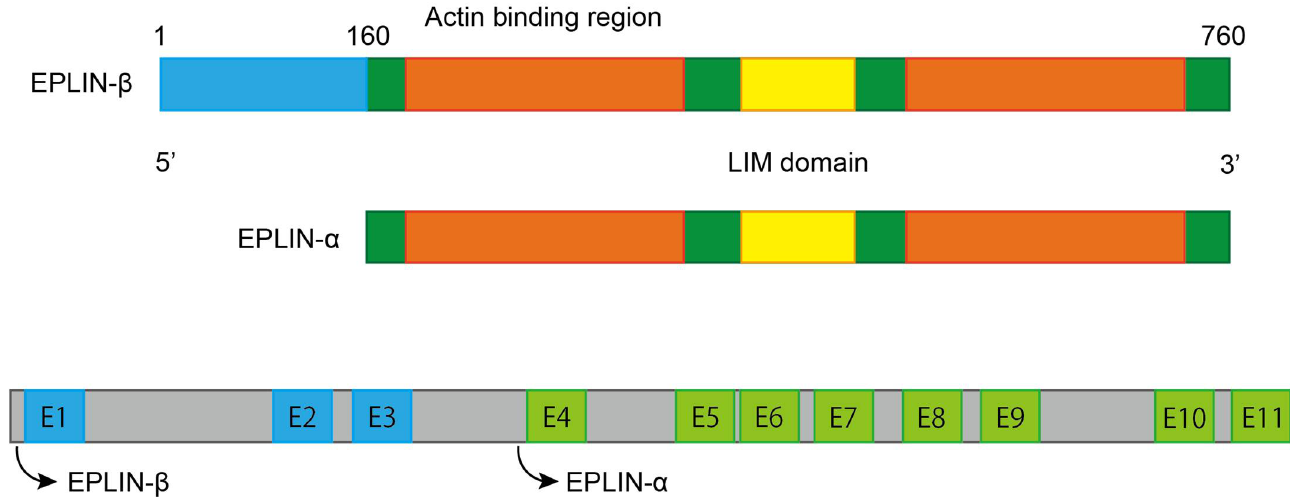
Figure 1. Schematic structure of EPLIN. Structural information is adapted from [5,6] and figure is designed and created by using Adobe Illustrator 2021Version 25.2.1 (Adobe Inc., San Jose, CA, USA).